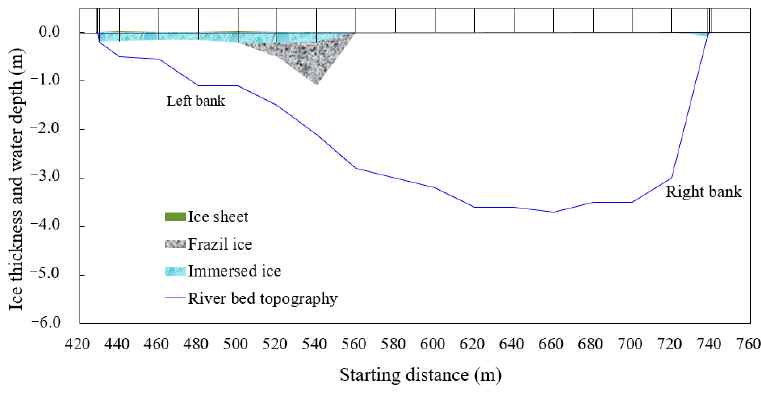
Figure 8. The water depth and ice condition distribution of open water leads.